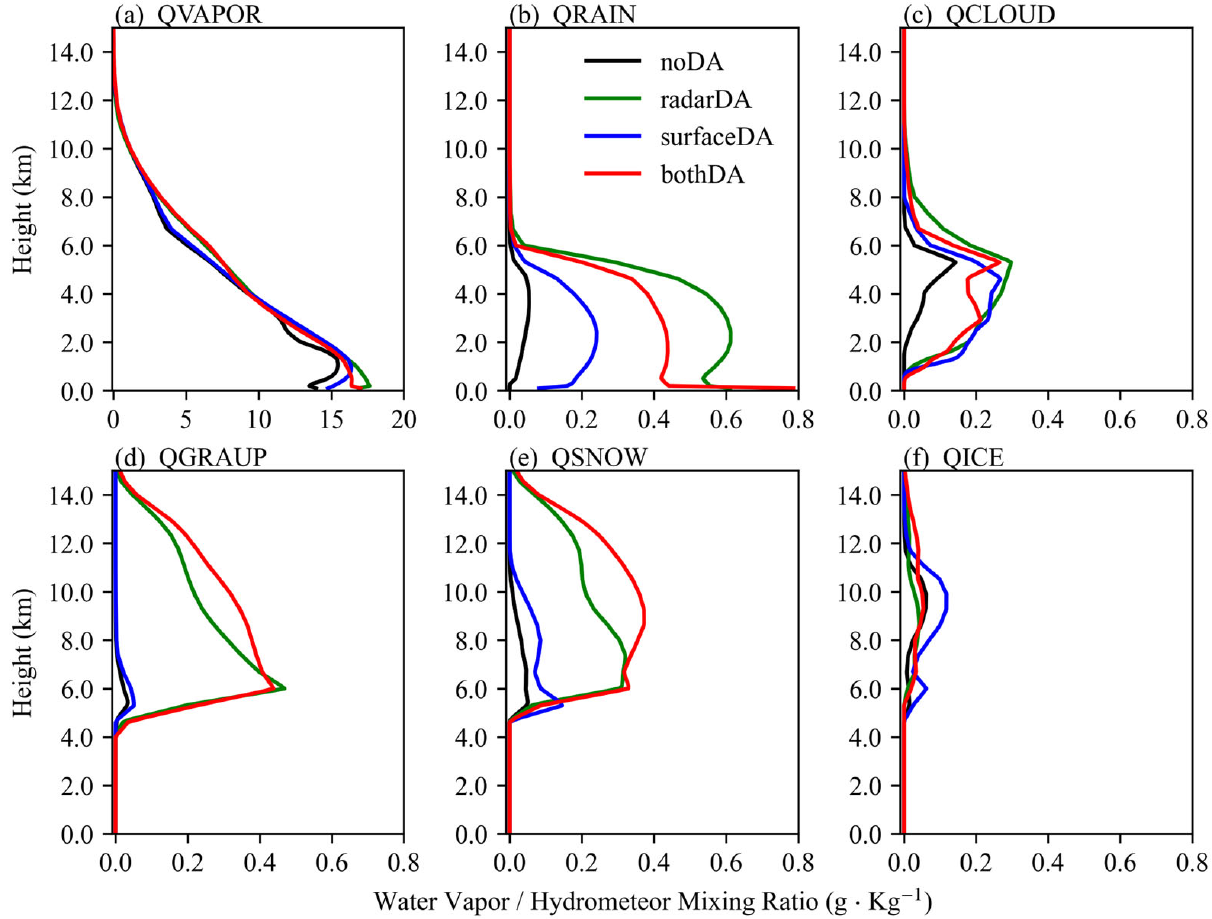
Figure 15. The vertical profiles of the area ‐ averaged ( a ) water vapor mixing ratio (QVAPOR), ( b ) rainwater mixing ratio (QRAIN), ( c ) cloud water mixing ratio (QCLOUD), ( d ) graupel mixing ratio (QGRAUP), ( e ) snow mixing ratio (QSNOW), ( f ) ice mixing ratio (QICE) at 1530 UTC 11 July 2014 for the noDA (black line), radarDA (green line), surfaceDA (blue line) and bothDA (red line) experiments. The black box in Figure 12 denotes the averaged area.